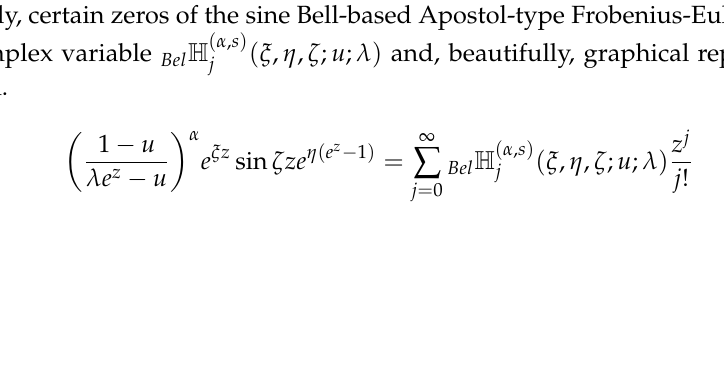
( α , c ) ( ξ , η , ζ ; u ; λ ) for 1 ≤ j ≤ 16. j